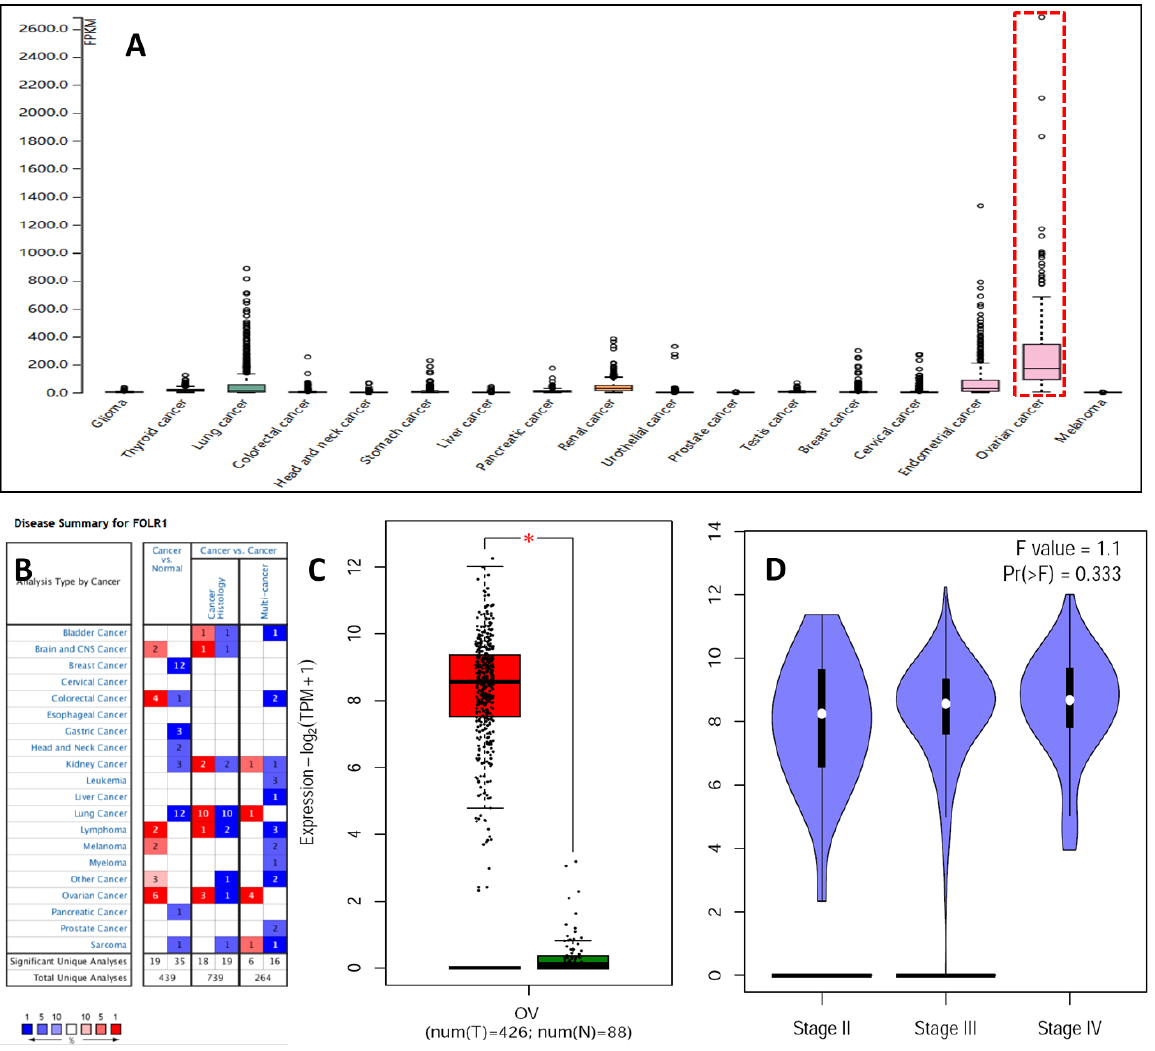
Figure 1: FOLR1 mRNA expression levels in different carcinomas (A: Box plot of FOLR1 mRNA expression levels in different cancers; B: FOLR1 was highly expressed in ovarian cancer tissues as compared to normal ovary tissues according to the Oncomine database; C: FOLR1 mRNA was upregulated in tumor tissues compared to the corresponding normal tissues of ovarian cancer patients according to the TCGA database; D: FOLR1 expression was not different between patients with different stages of ovarian